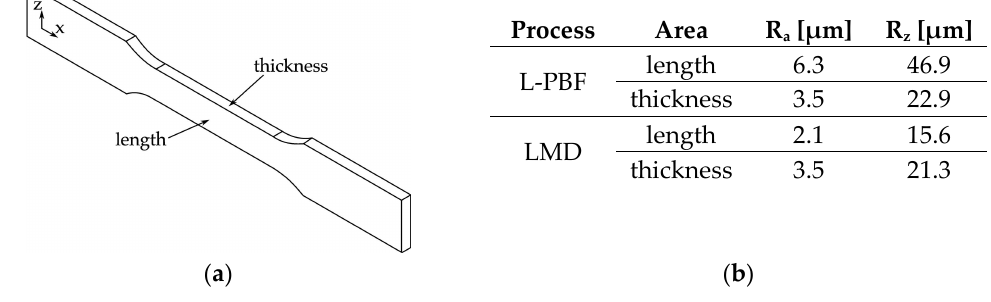
Figure 10. ( a ) Sketch of samples; ( b ) table with results of the roughness measurement.